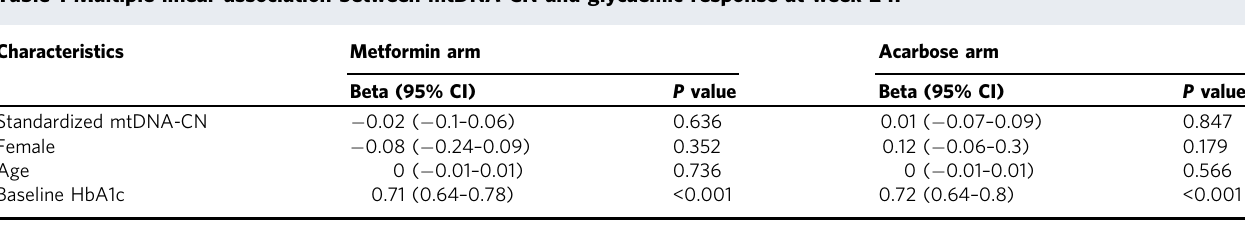
Table 1 Multiple linear association between mtDNA-CN and glycaemic response at week 24. Characteristics